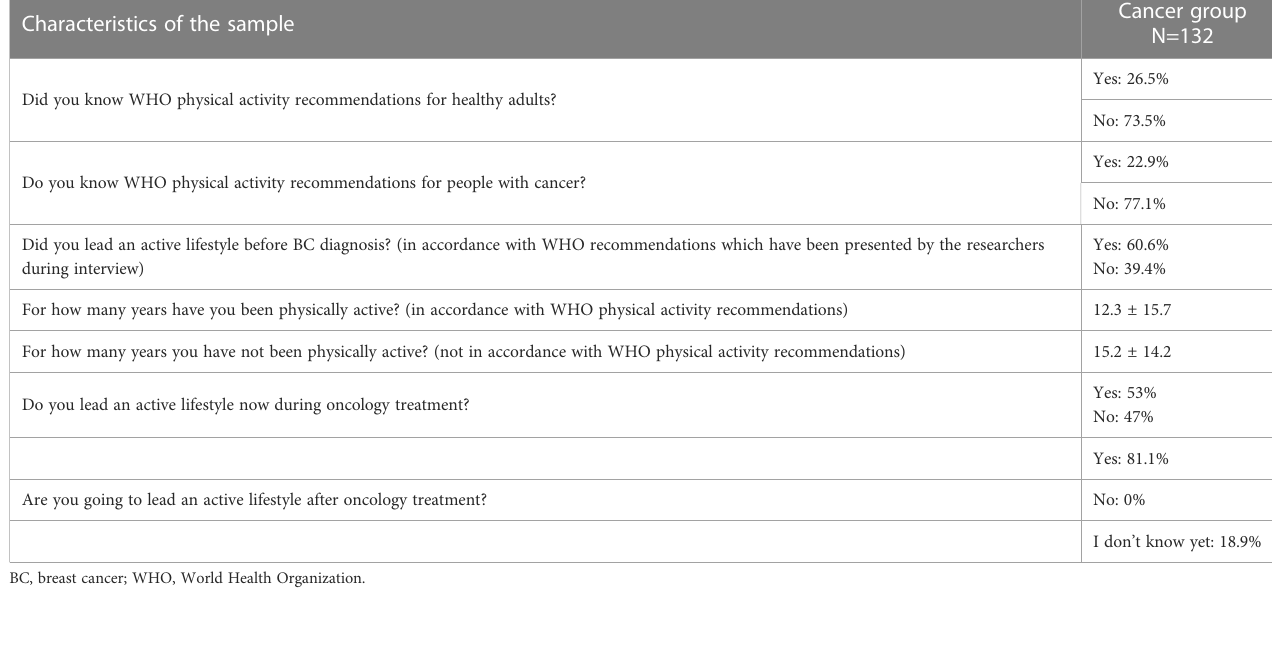
TABLE 2 Lifestyle of BC patients (N=132).